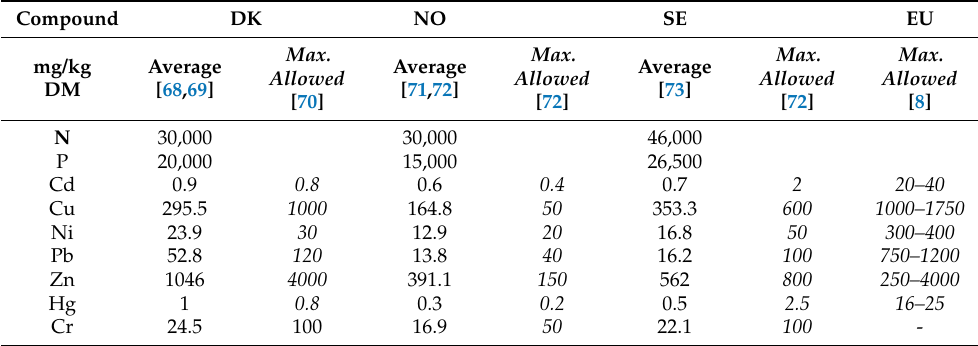
Table 3. Summary of sludge average composition of nutrients and heavy metals, including the maximum allowed concentrations of the different compounds (in italics). References are presented in square brackets. DK, Denmark; EU, Europe; NO, Norway; SE, Sweden. Compound DK